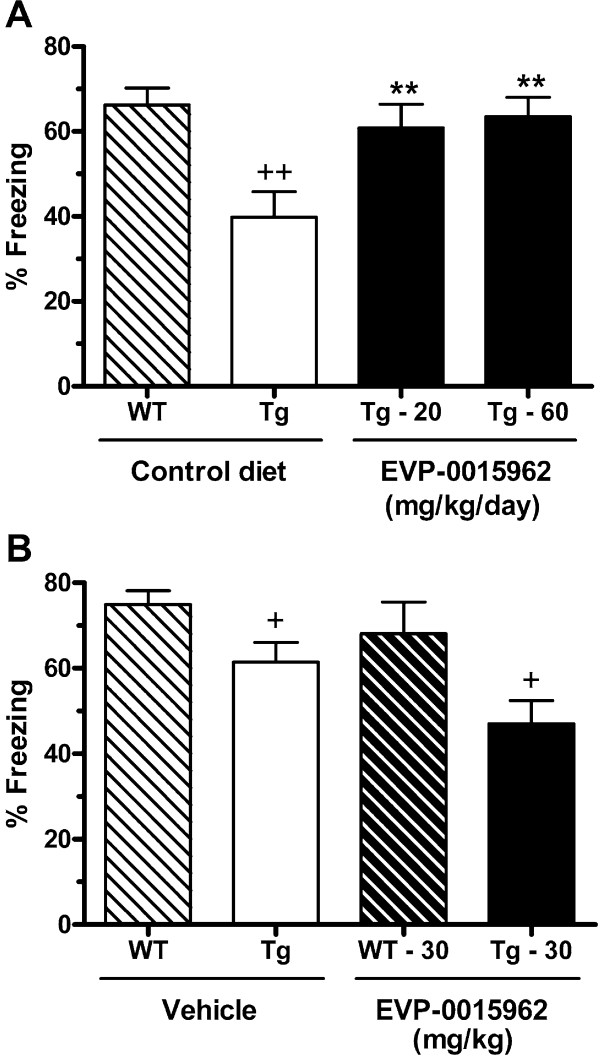
Chronic daily exposure to EVP-0015962 in Tg2576 mice reverses a cognitive decline. A. Percent freezing in the CFC behavioral assay after chronic treatment with EVP-0015962 for 11 weeks in wild type (WT) and Tg2576 (Tg) mice, aged 30–33 weeks. Difference between WT and Tg2576 mice on control diet (i.e., genotype effect): ++p < 0.01. Differences from Tg2576 mice on control diet (i.e., treatment effect): **p < 0.01. N = 10–15 mice per group. B. Percent freezing comparing WT and Tg2576 at 30 weeks of age and treated with a single acute dose of 30 mg/kg, p.o. of EVP-0015962 or vehicle. Differences from WT mice receiving the same treatment, either vehicle or 30 mg/kg of EVP-0015962: +p < 0.05, indicating a genotype effect but no treatment effect. N = 10–15 mice per group. All statistical analyses were performed with 1-way ANOVAs and post-hoc Newman-Keuls tests or t-tests.